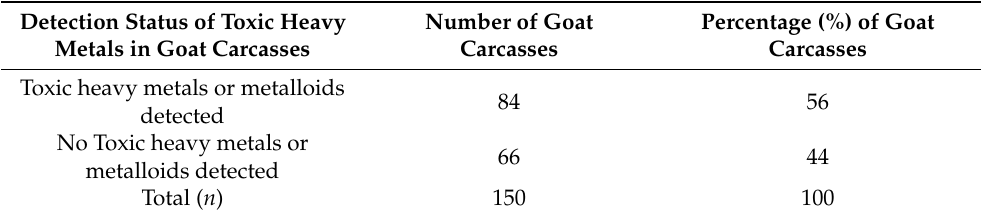
Table 2. Percentage (%) detection of toxic heavy metals (THMs) in goat carcasses ( n = 150) processed for human consumption in Enugu State,